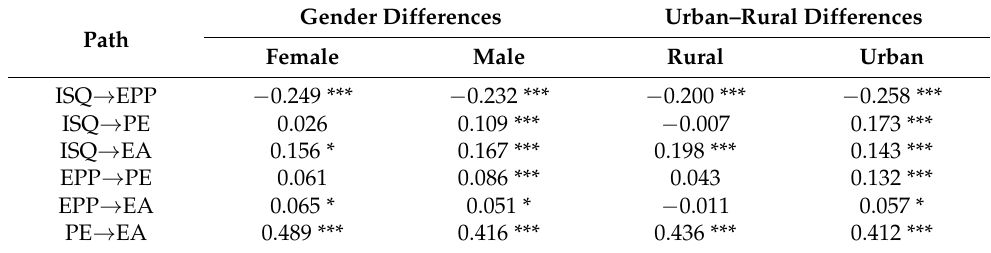
Table 6. Heterogeneity